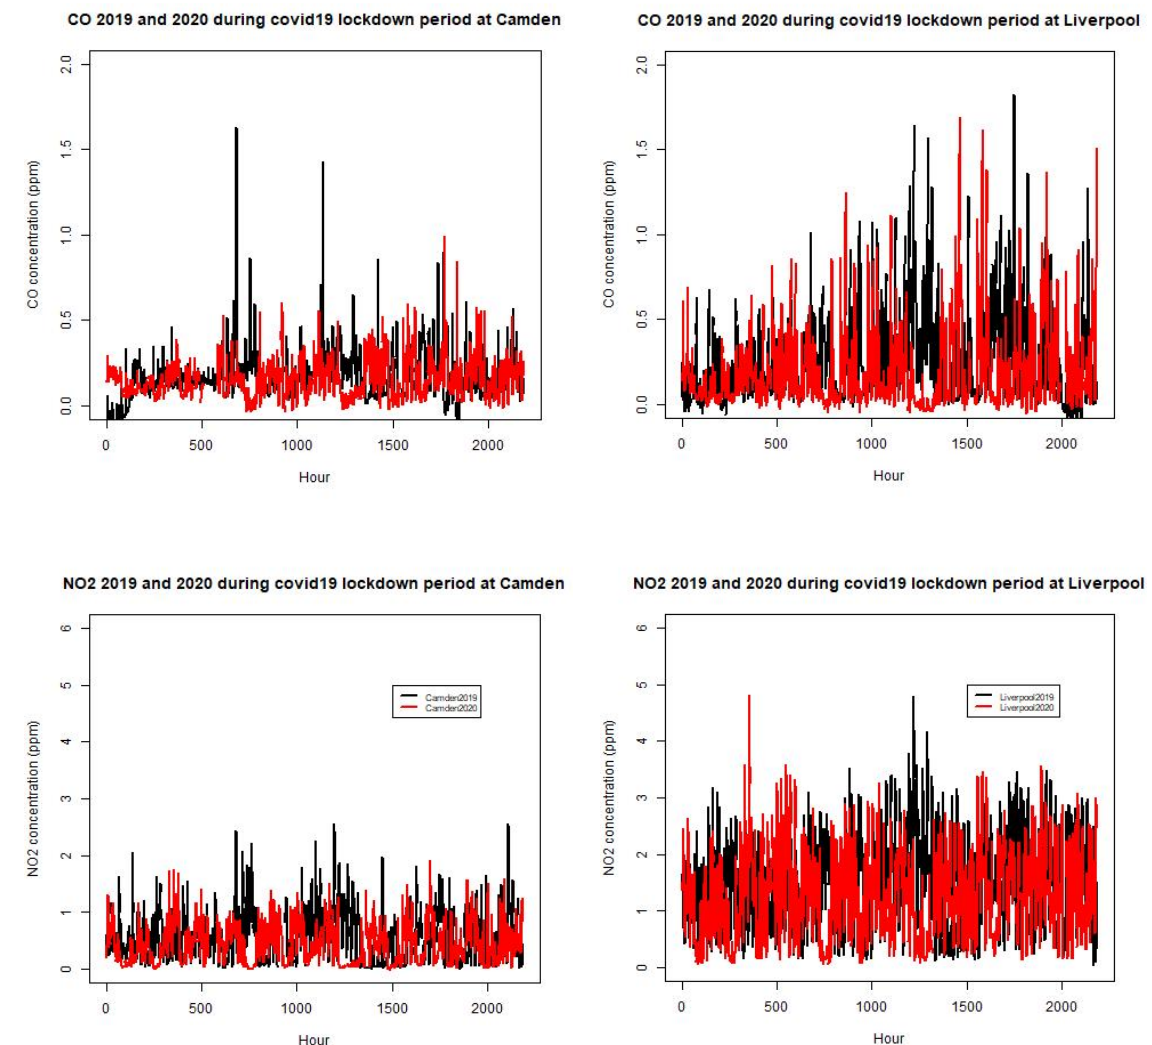
Figure 7. Time series of CO and NO 2 at Camden and Liverpool for 2019 and 2020 during the April to June period (red as 2020 series, black as 2019 series).